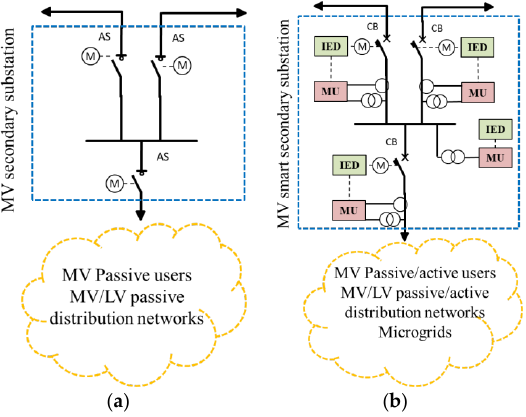
Figure 2. Schematic representation of ( a ) conventional secondary substation, ( b ) smart secondary substation.